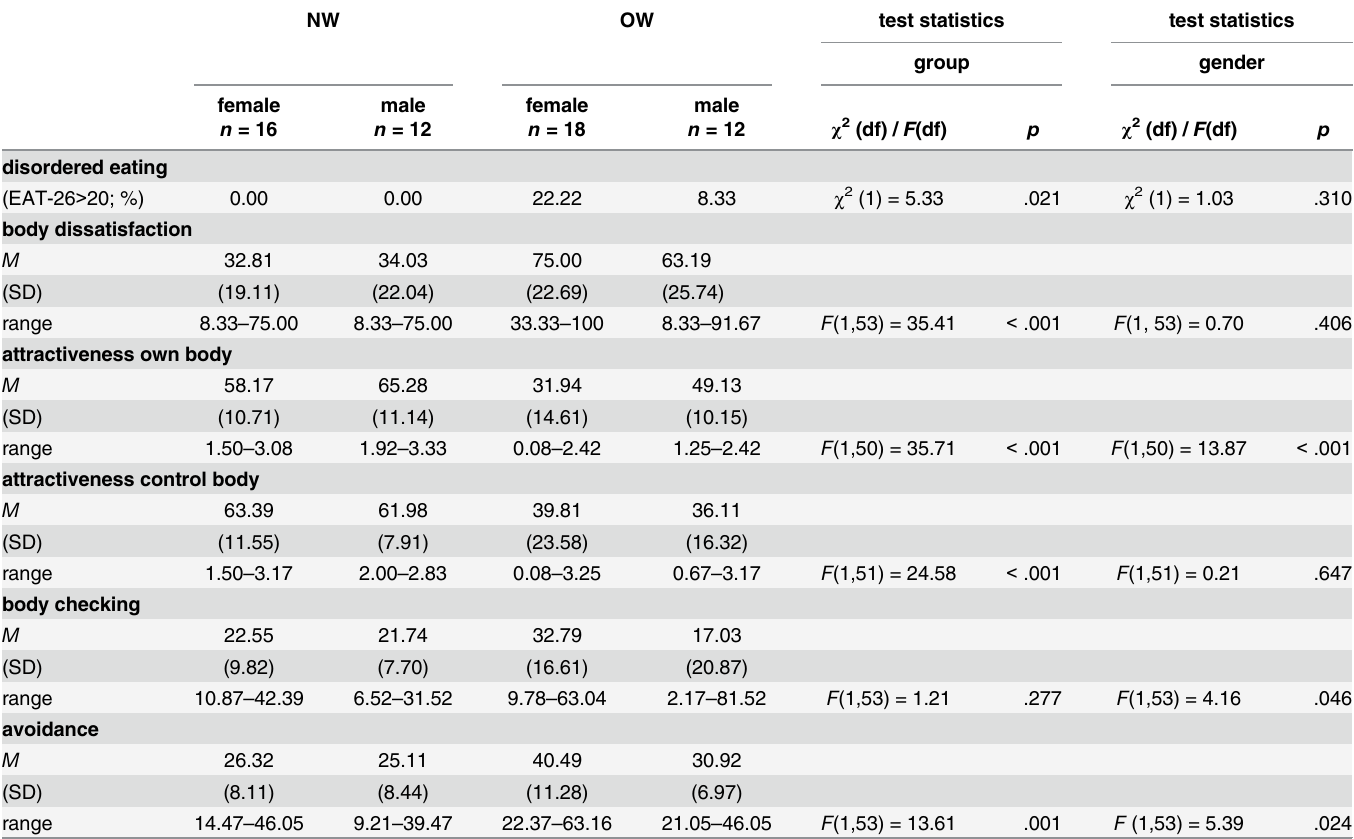
Table 2. Descriptive results for body image-related